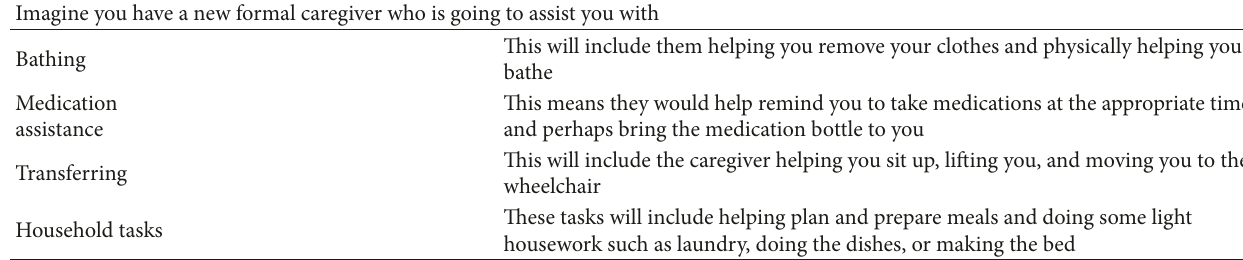
Table 3: Scenario descriptions for each task.